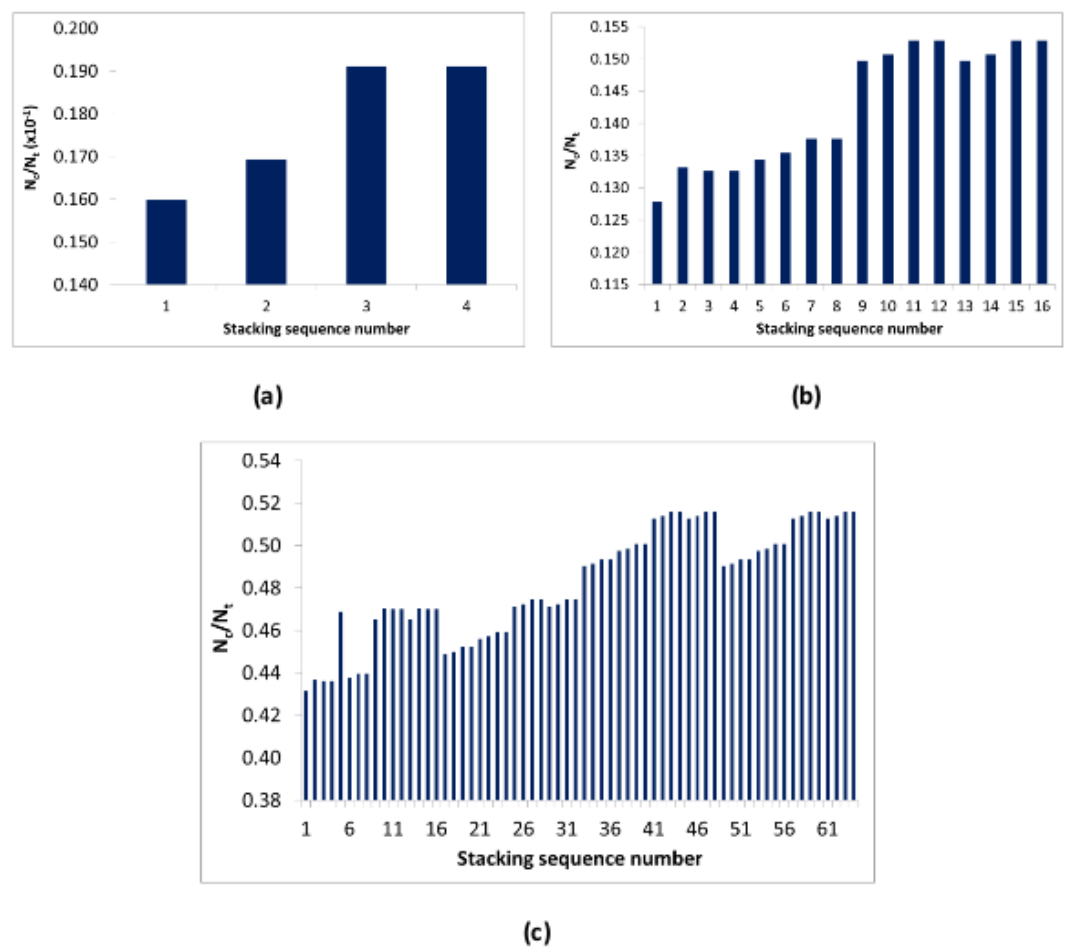
Figure 7: Ratio of N C / N t for all possible combinations of stacking sequence of symmetric UD laminates from 4 fibre orientation and made of (a) 2 layers, (b) 4 layers, (c) 6 layers. Set target buckling load is 200 N/mm. All